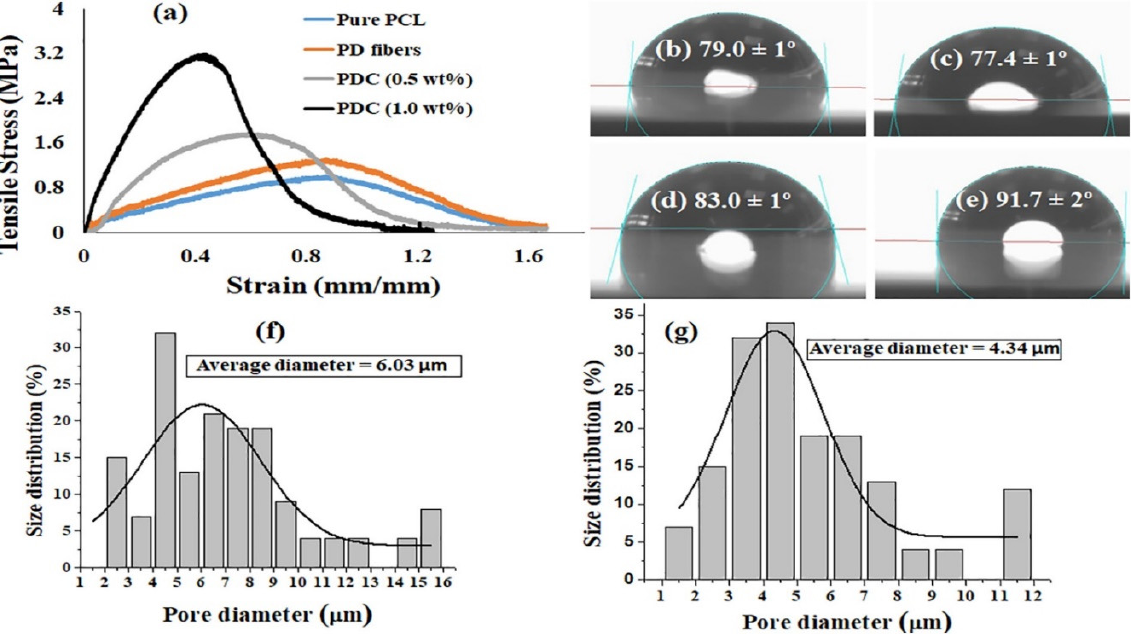
Figure 7. ( a ) Tensile graphs; ( b – e ) contact angles of neat PCL, PD, PDC (0.5 wt.%), and PDC (1.0 wt.%); and ( f , g ) poros- ity/permeability of PDC (0.5 wt.%) and PDC (1.0 wt.%) composite filaments. Reproduced with permission from [297].